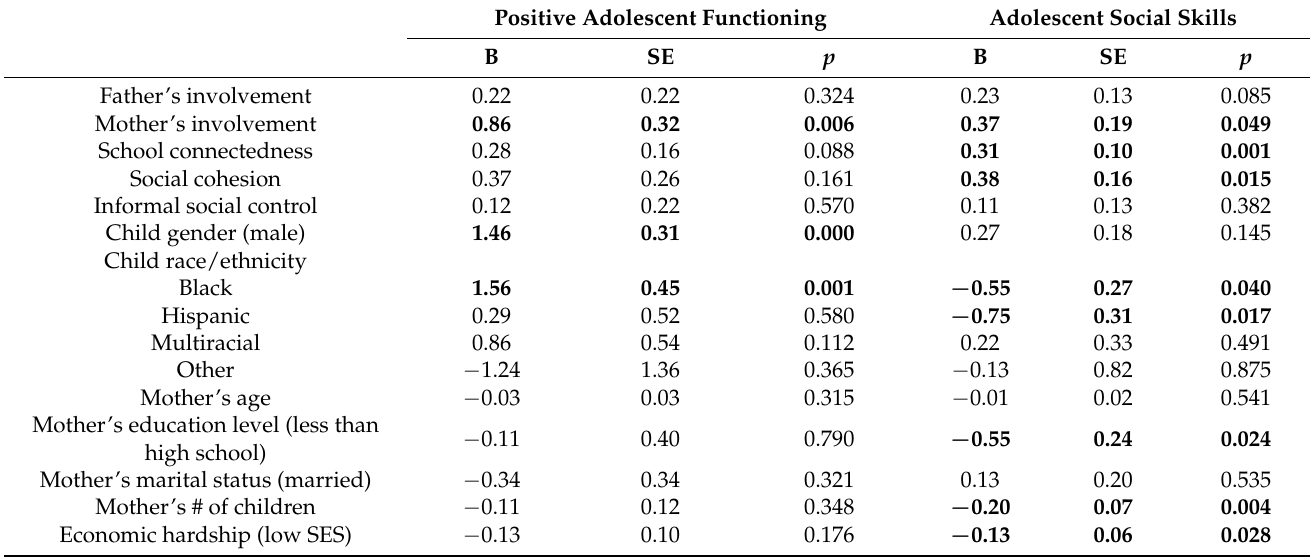
Table 3. Predictors of positive adolescent functioning and adolescent social skills (N =